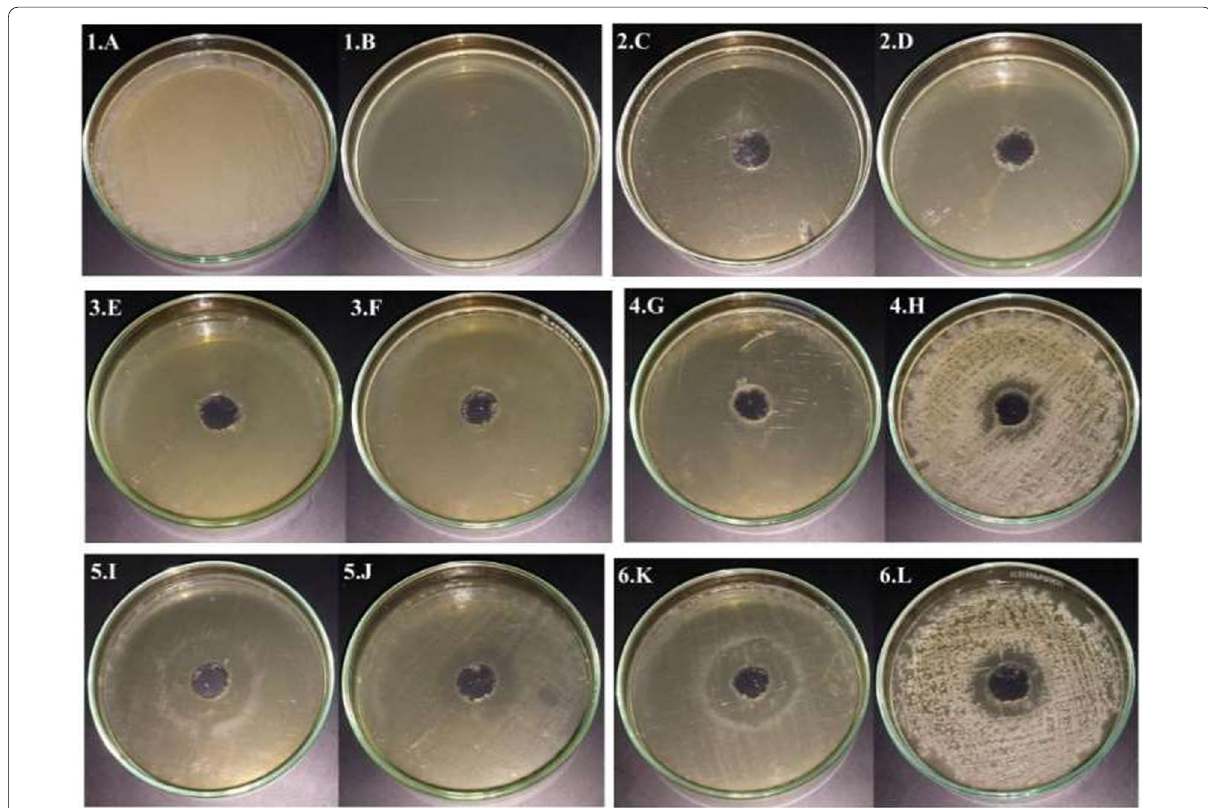
Fig. 7 The highest inhibition zones formed by LAB over different incubation periods, 1. Control 1A: -ve Control, and 1B: sp . MK780212 (After 24 h of incubation) 2C: Free LAB and 2D: encapsulated, 3. Lactobacillus kunkeei MK780218 (After 24 h incubation) 3E: Free